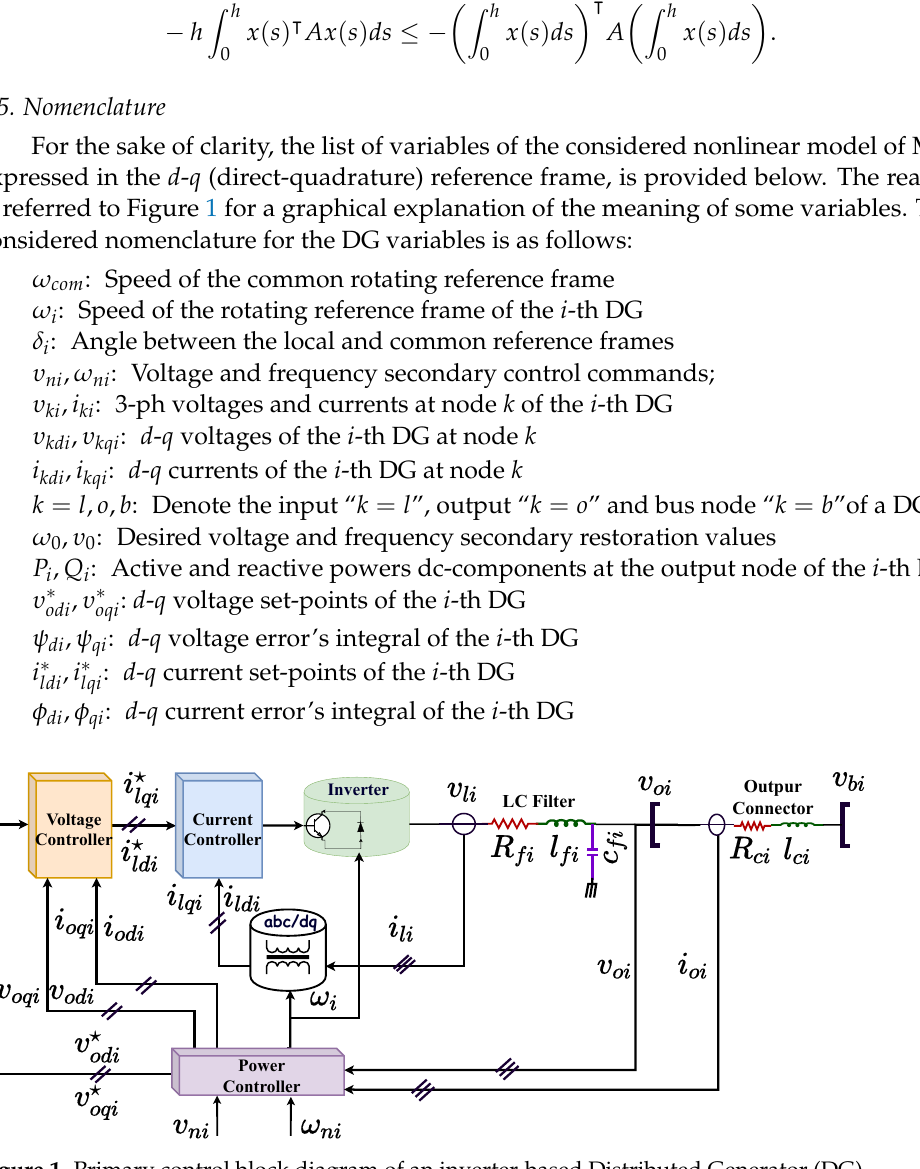
Figure 1. Primary control block diagram of an inverter-based Distributed Generator